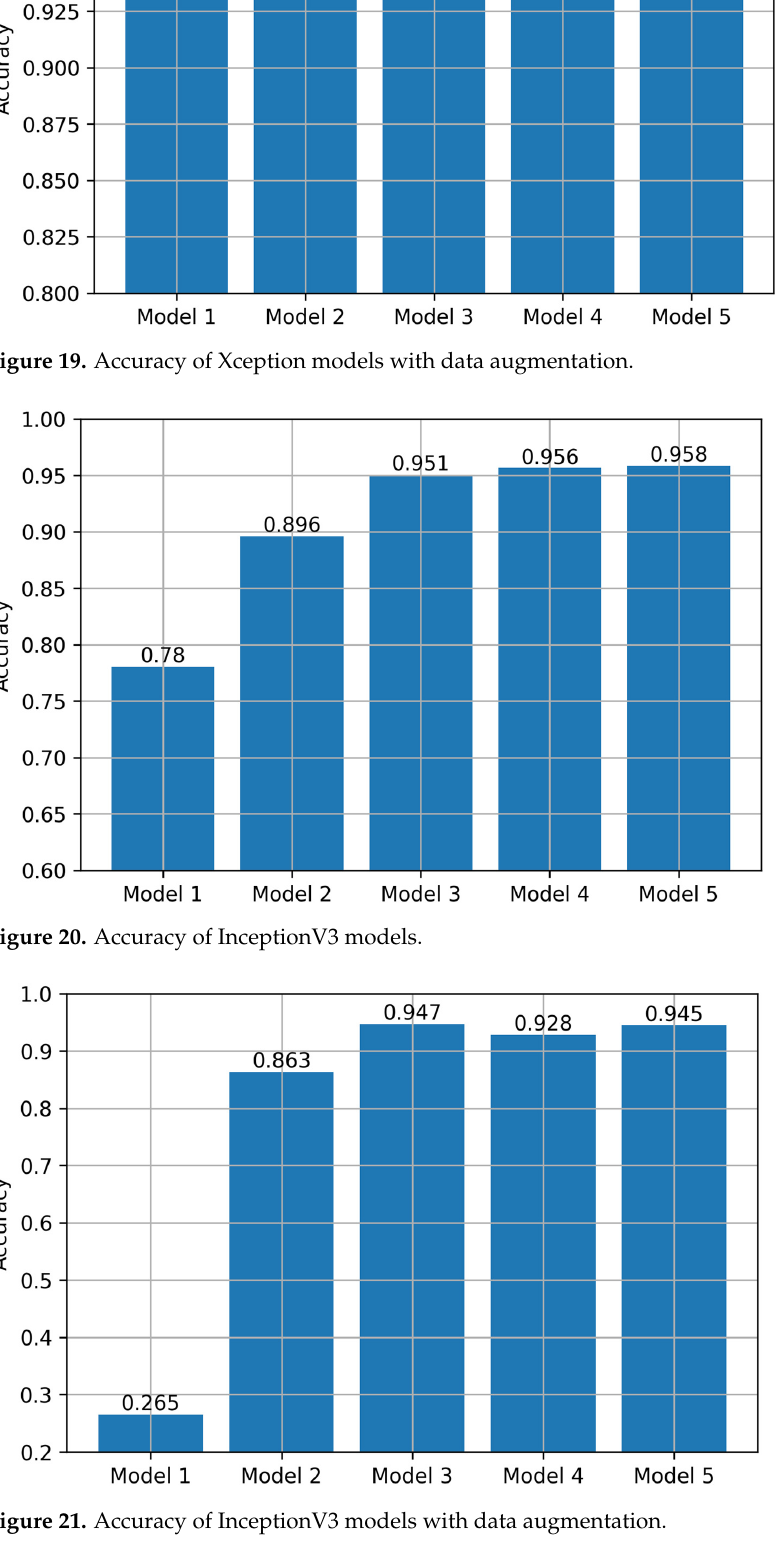
Figure 21. Accuracy of InceptionV3 models with data augmentation.